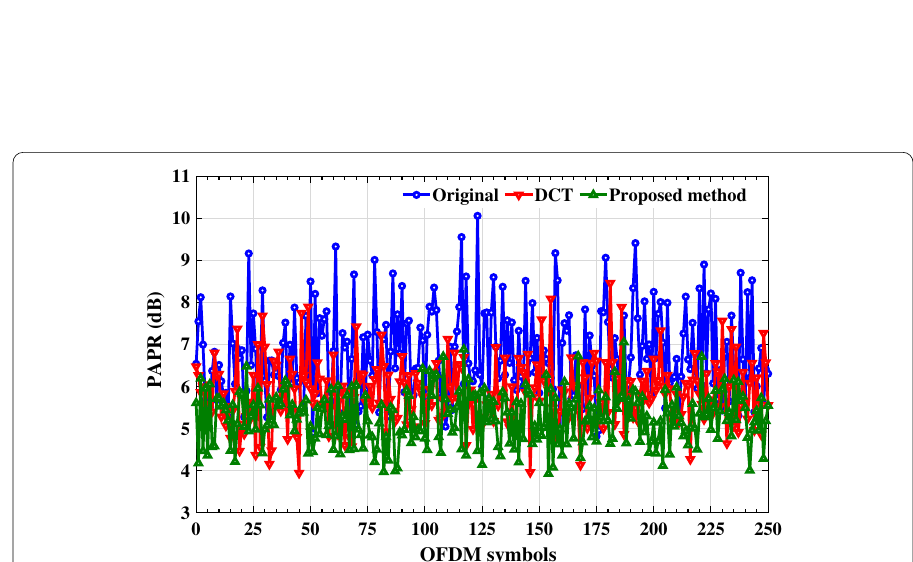
Fig. 10 Comparison of PAPR values versus OFDM